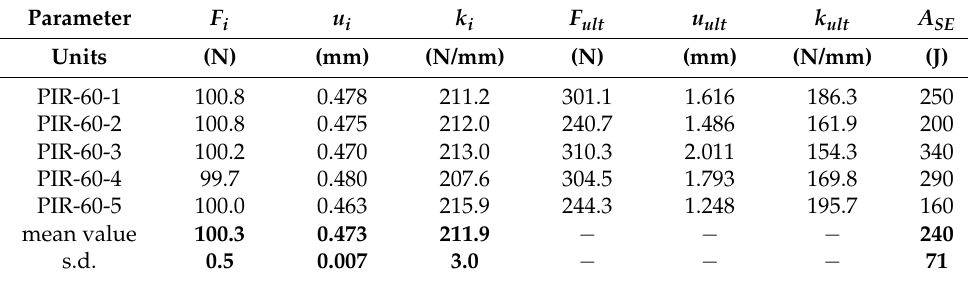
Table 1. Results from laboratory tests.